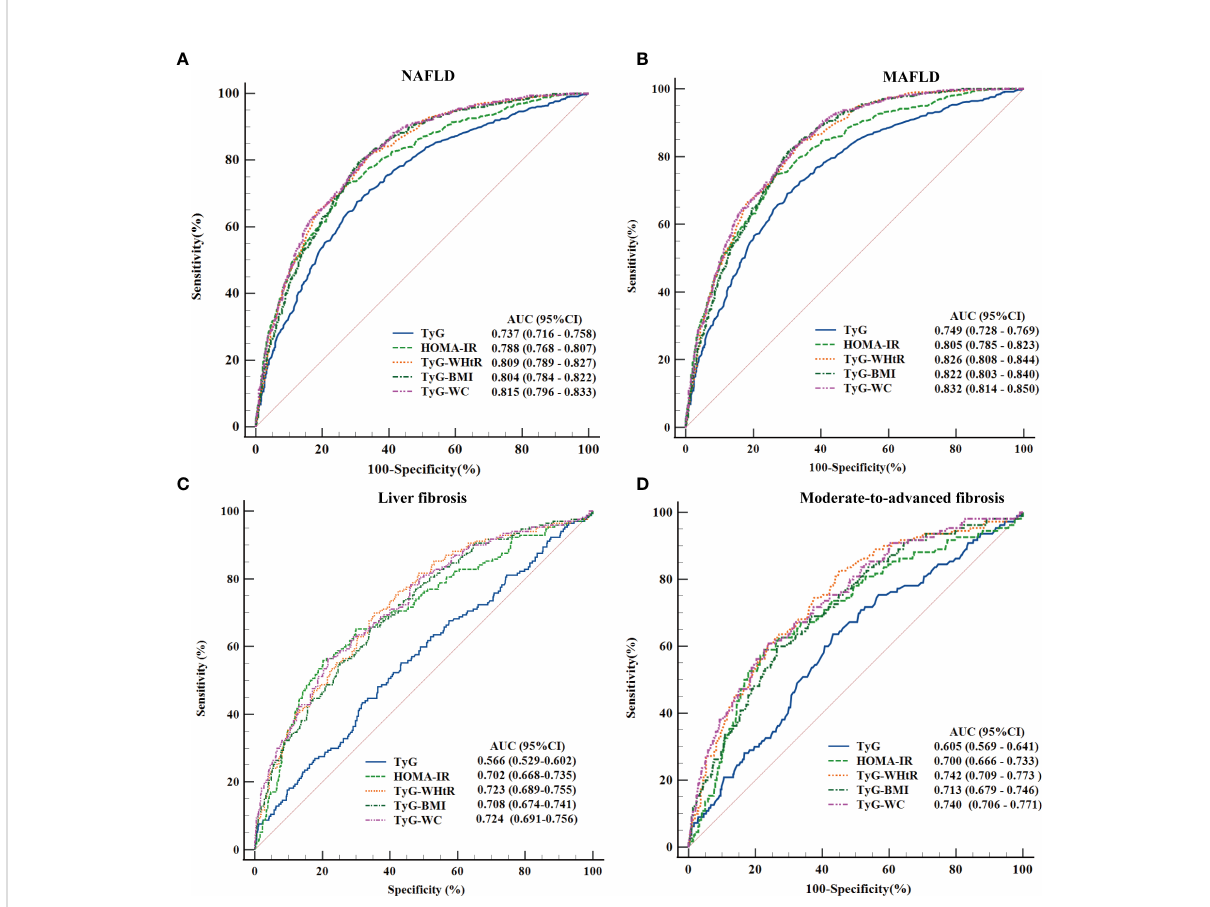
FIGURE 3 Receiver operating characteristic (ROC) curves and the area under the ROC curve (AUC) values of the fi ve parameters (TyG index, HOMA-IR score, TyG-WHtR, TyG-BMI, and TyG-WC) in diagnosing NAFLD, metabolic-associated fatty liver disease (MAFLD), liver fi brosis, and moderate- to-advanced fi brosis. (A) Five parameters were assessed to identify NAFLD. (B) Five parameters were assessed to identify MAFLD. (C) Five parameters were assessed to identify liver fi brosis. (D) Five parameters were evaluated to identify moderate-to-advanced fi